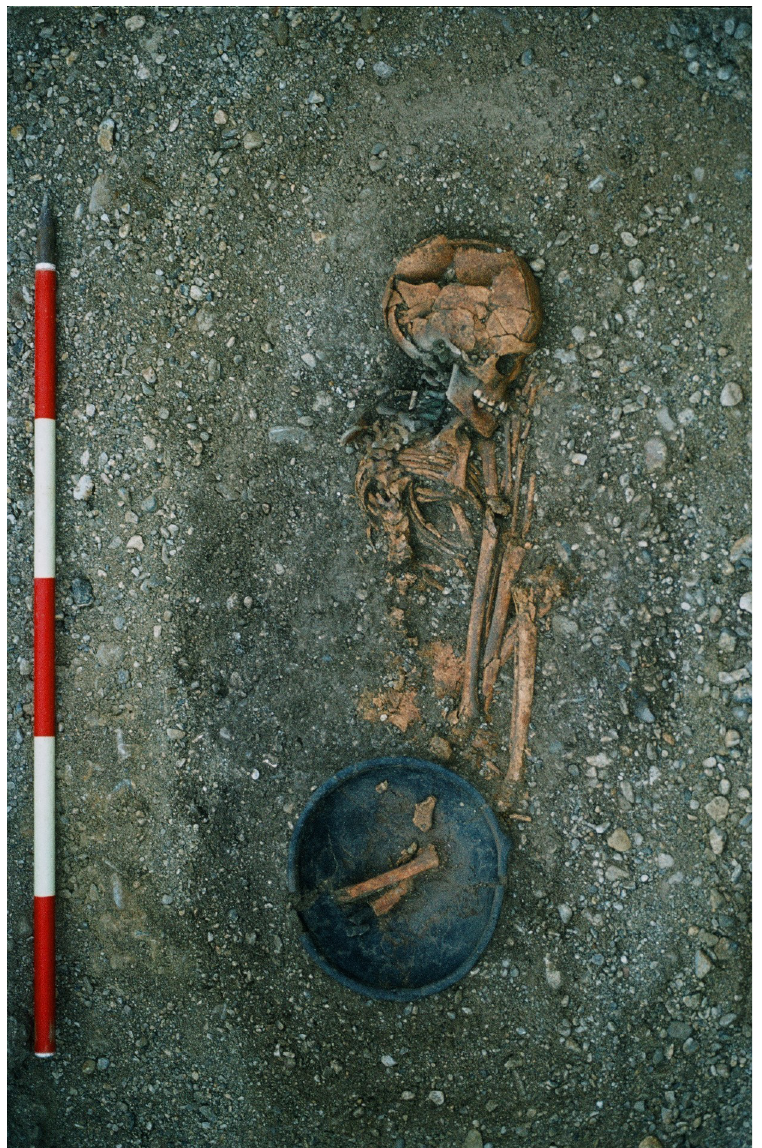
Fig 1. Burial of a 7-9-year old boy at Franzhausen I, Austria (Verf. 290) in flexed body position typical for males (left body side, north-south orientation) © Bundesdenkmalamt Wien/NO¨.